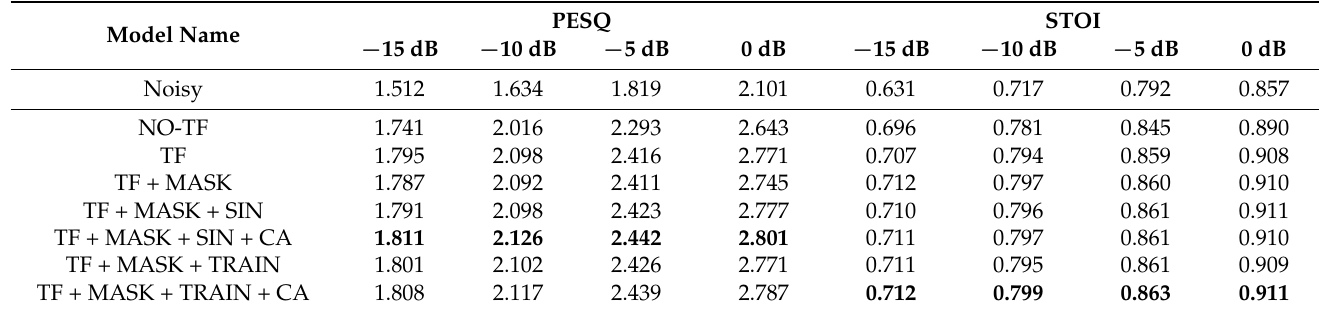
Table 7. Ablation experiments in the MUSAN test set.